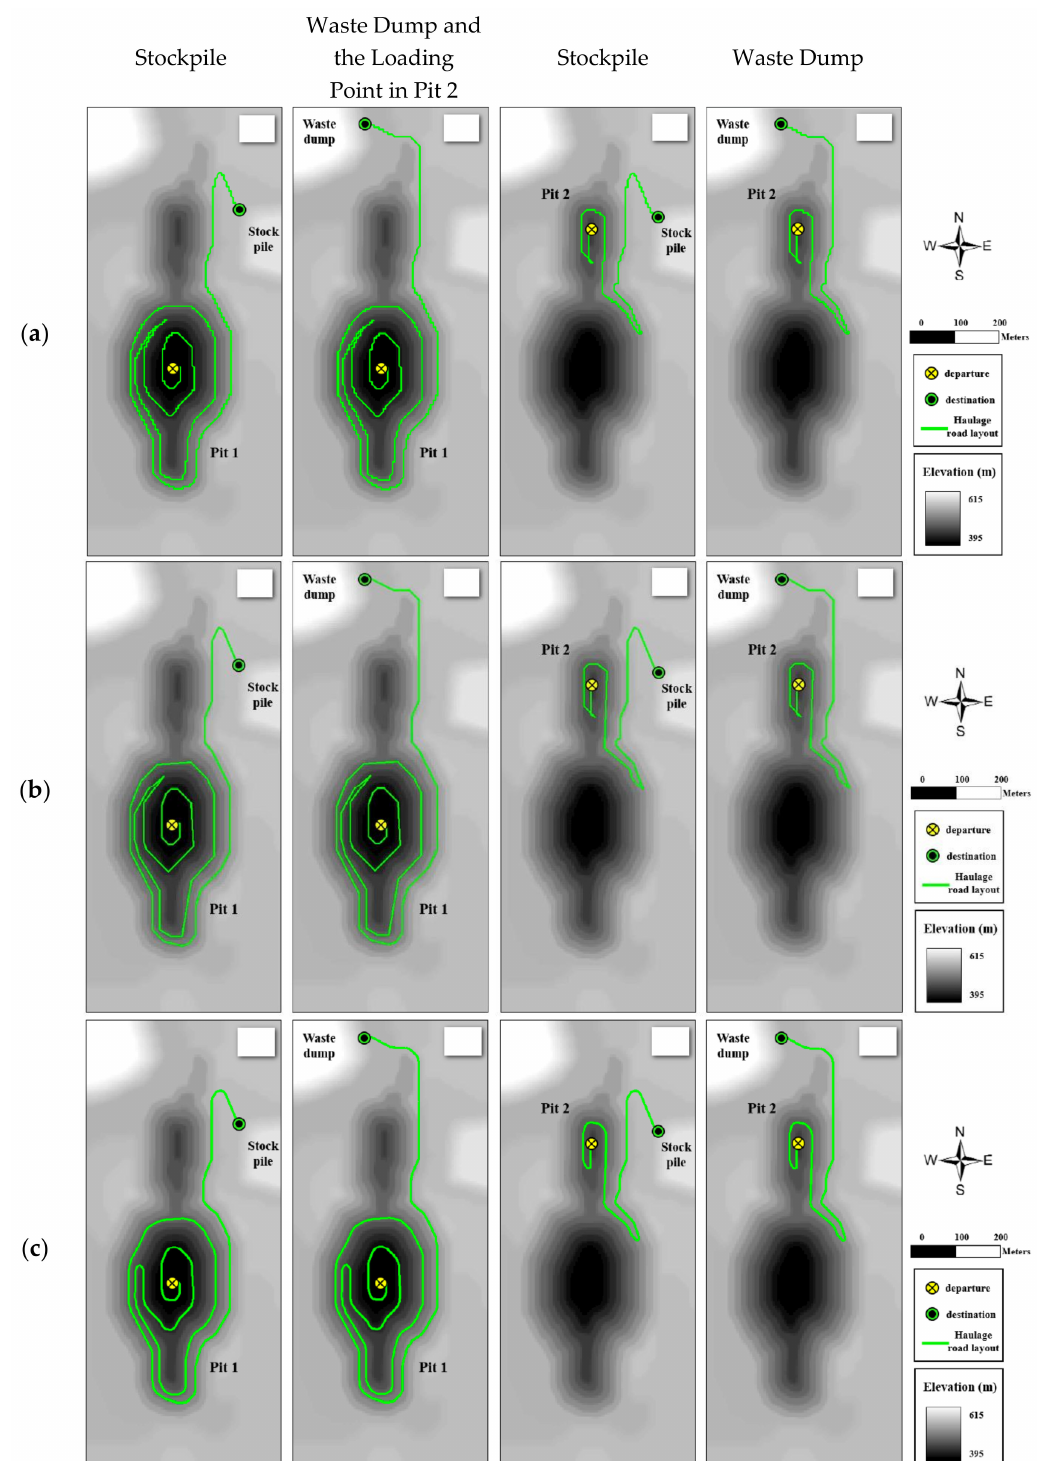
Figure 8. Results of analyzing the 2D haul road. ( a ) Haul road layout in the pit 1 and pit 2 areas analyzed using least-cost path analysis (LCPA). ( b ) Simplification of the haul road layout of pit 1 and pit 2. ( c ) Results of modifying the road layout in pit 1 and pit 2 by considering the radius of curvature (modified from Baek et al.